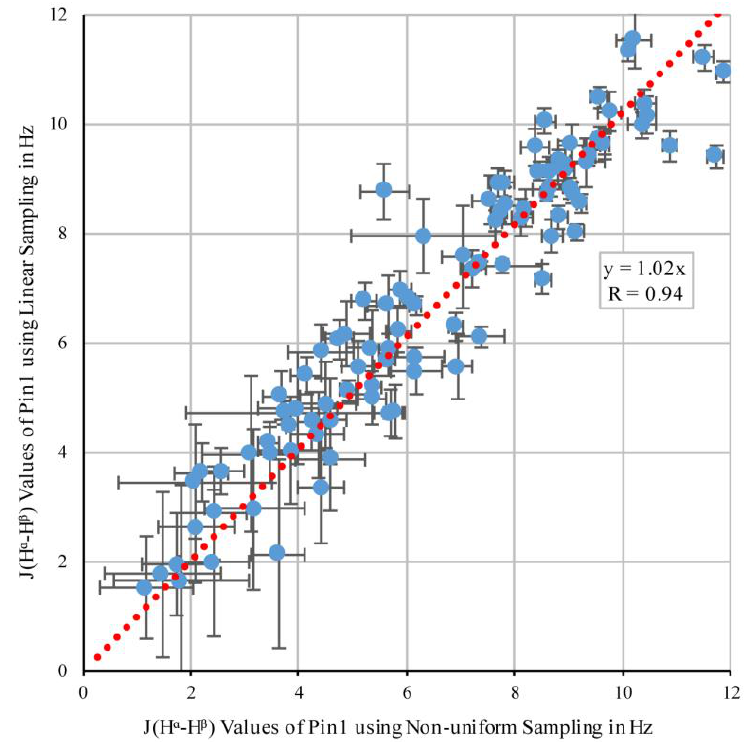
Figure 5. Correlation between 3 J Hα–Hβ coupling values in Pin1 obtained from non-uniform and linear sampling. The error bars were calculated using Equation (2).